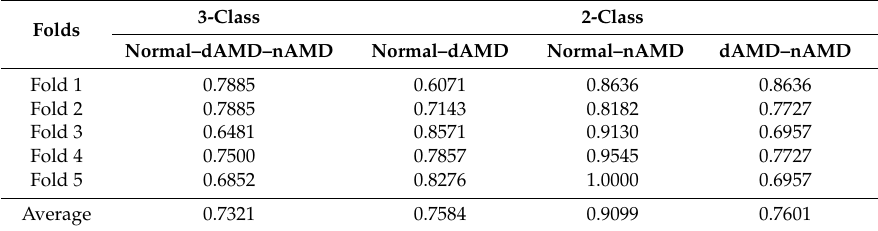
Table 5. Results obtained using five-fold cross-validation and ultra-widefield images. Folds